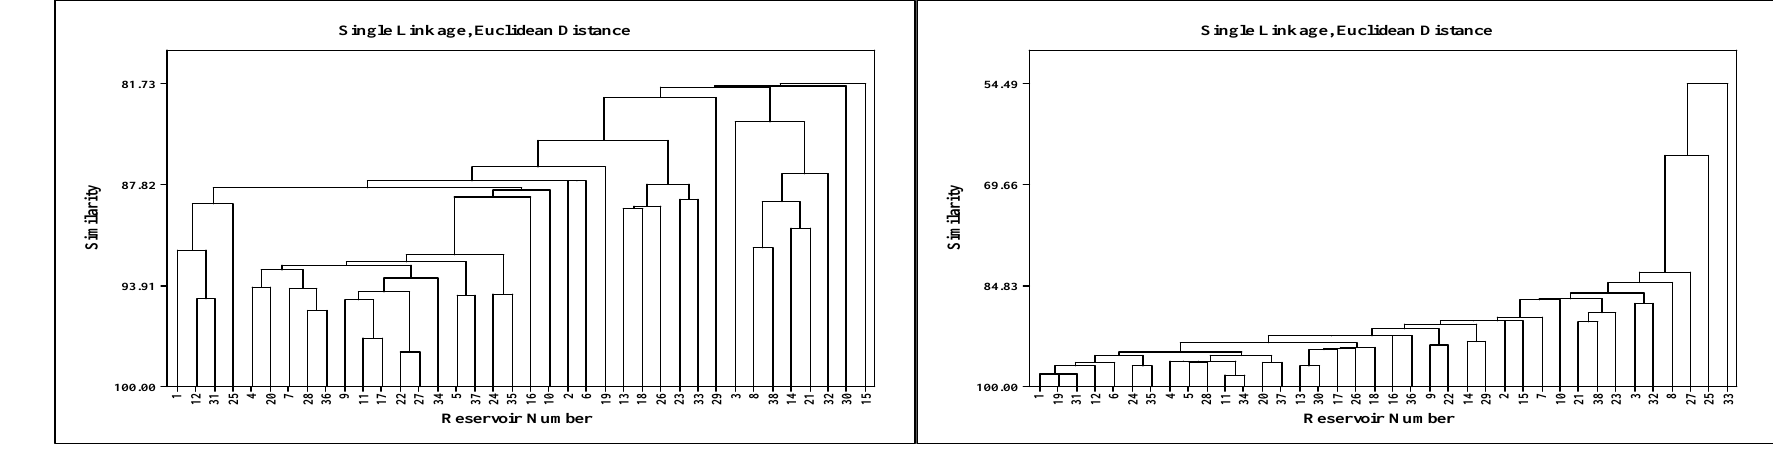
Figure 2 : Dendrogram showing the similarity of study sites based on measured environmental variables during wet season (a) and during dry season (b). Reservoir